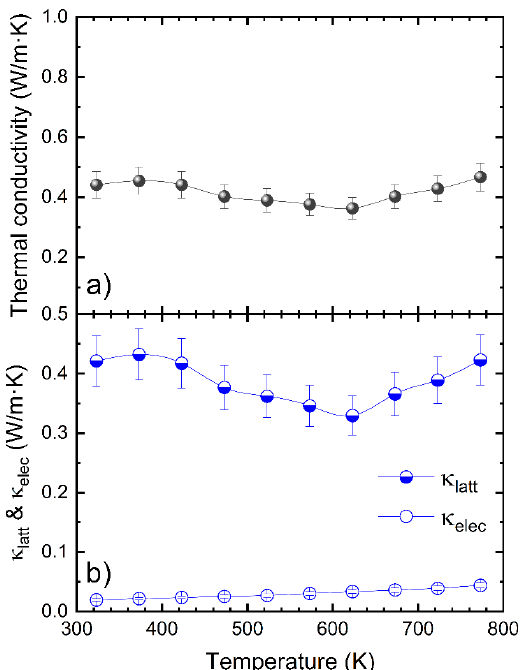
Figure 5. ( a ) Total and ( b ) lattice and electronic contributions to the thermal conductivity as a function of temperature for the AgSbTe 2 compound. There is an increase in the lattice thermal conductivity at 623 K, probably related to the effect of the atomic ordering happening around that temperature range.